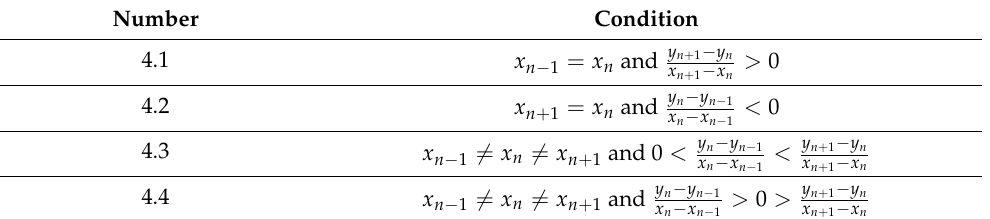
Table 1. First conditions for detection based on